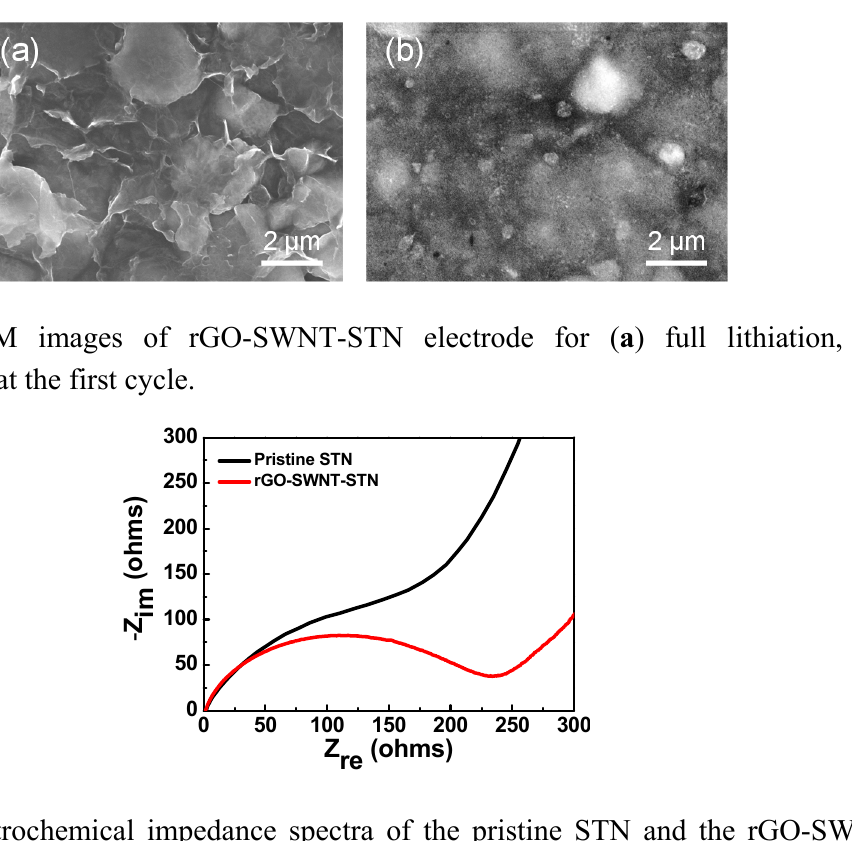
Figure 7. Electrochemical impedance spectra of the pristine STN and the rGO-SWNT- STN